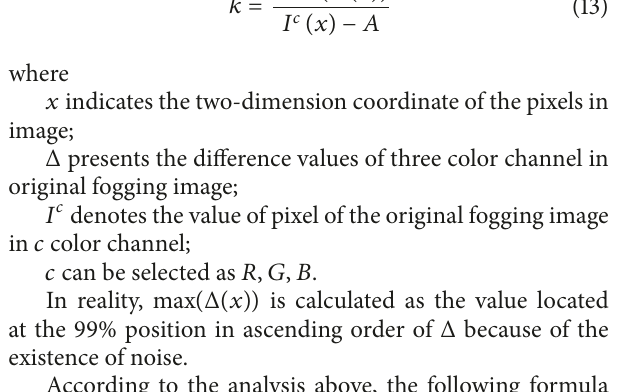
three color channels’ maximum difference value before defogging three color channels’ maximum difference value after defogging